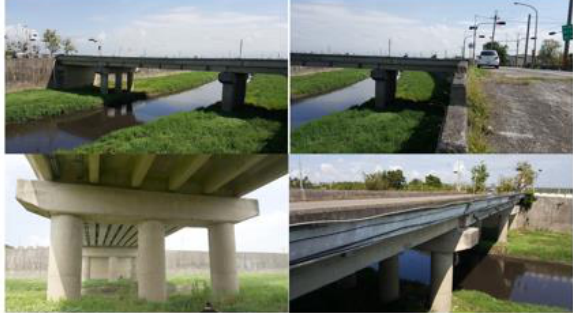
Figure 4. The outward appearance of Chia-Nan Bridge#2